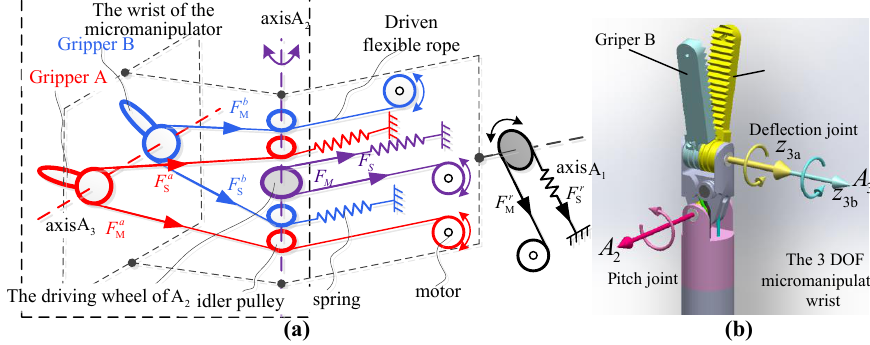
Figure 2. (a) Cable-driven mechanism of the micromanipulator. (b) The 3-D model of the micromanipulator wrist.